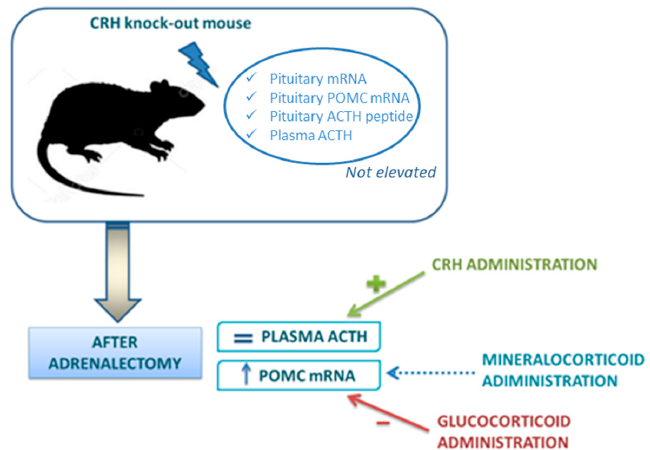
Figure 2. Corticotropin-release hormone (CRH) knock-out (KO) mouse model in regulation of hypothalamus-pituitary-adrenal (HPA) axis [59]. In CRH KO models proopiomelanocortin (POMC) mRNA, but not plasmatic adrenocorticotropic hormone (ACTH), rises after adrenalectomy. Glucocorticoids, but not mineralocorticoids (blue dotted arrow) reduce POMC increase induced by adrenalectomy. CRH administration restores a significant ACTH secretion.